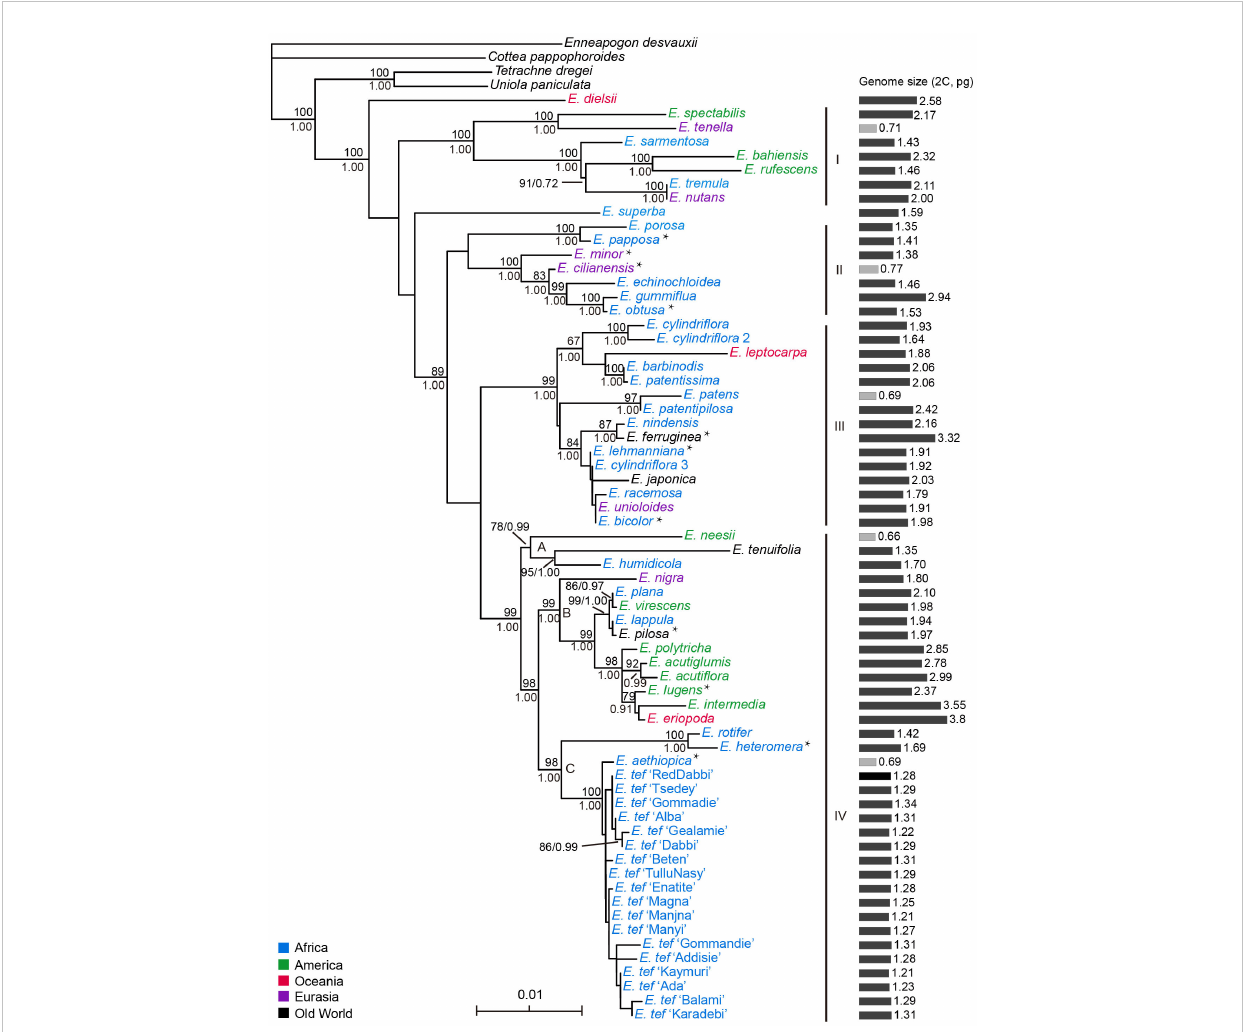
FIGURE 1 Phylogenetic relationships and genome sizes of Eragrostis species. Phylogram of best maximum likelihood tree reconstructed by combined plastid and nuclear ITS data. Numbers above branches are BS values larger than 50%. Numbers below branches are PP values of the Bayesian tree. Taxon color in Eragrostis clade corresponding to the centralized distribution area as follows: Africa = blue, America (North America and South America) = green, Australia (or Oceania) = red, Eurasia = purple, Old World = black. “ Old World ” refers to Europe, Africa, and Asia. Genome sizes (2C, pg) of Eragrostis species are presented in grey bars on the right side with small genomes indicated in light grey. *, asterisks represent presumed ancestors of Eragrostis tef in Girma et al.